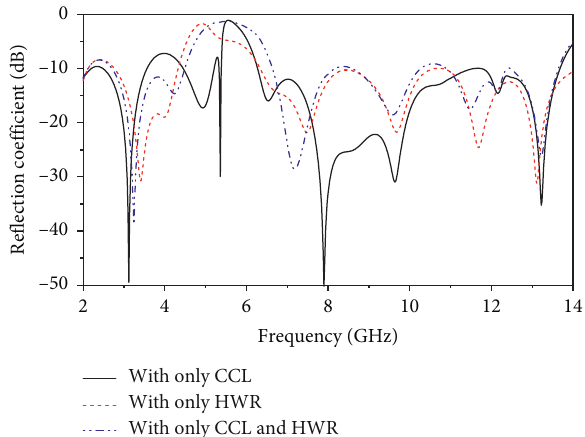
Figure 7: Simulated characteristic of the Vivaldi antenna for different